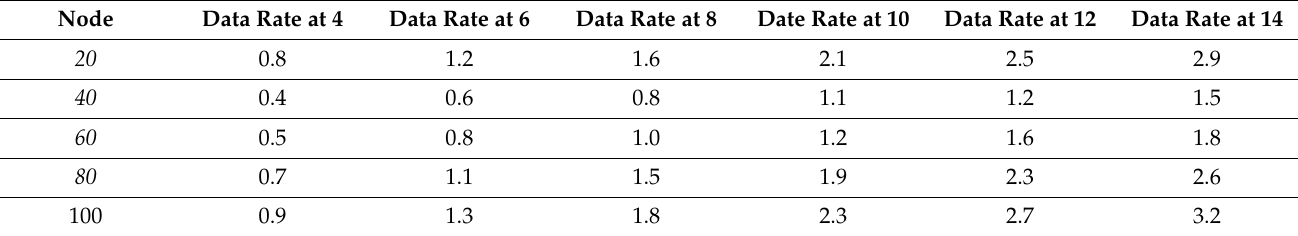
Table 4. Energy consumption based on data